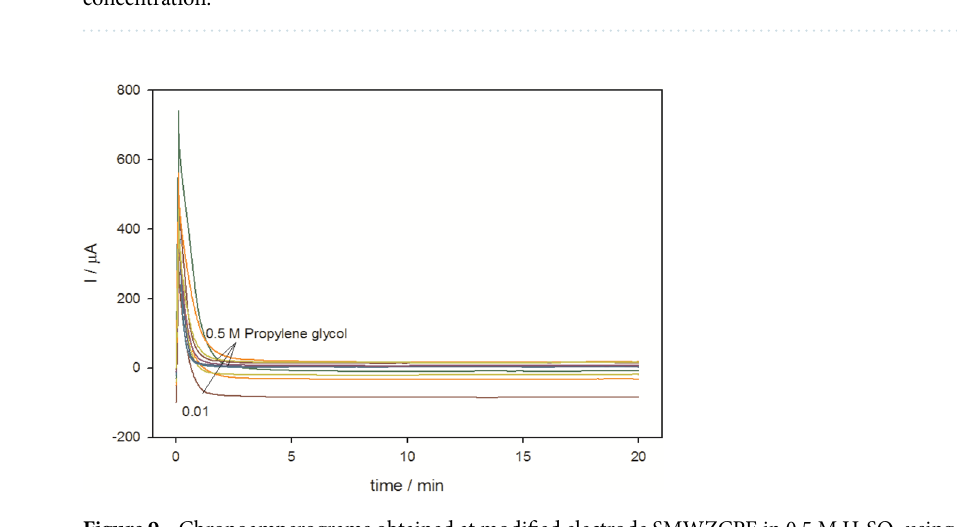
Figure 9. Chronoamperograms obtained at modified electrode SMWZCPE in 0.5 M H 2 SO 4 using changed concentrations from (0.01–0.5 M) propylene